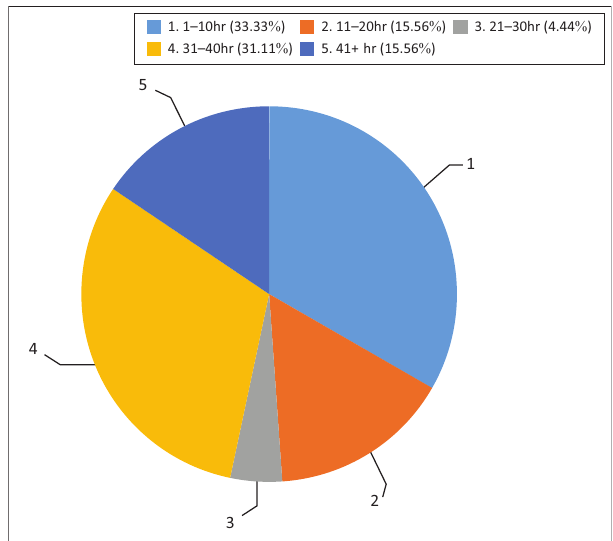
FIGURE 2: Number of hours spent on clinical practice tasks on a weekly